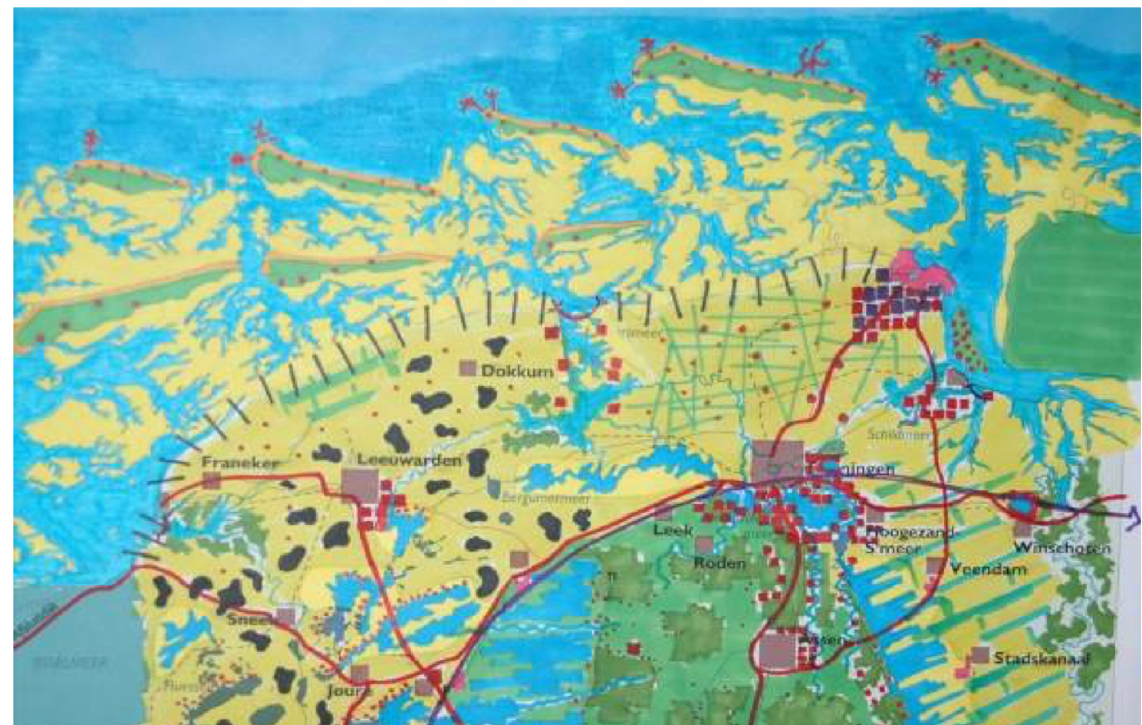
Figure 1. Plan for Double Defence (Roggema et al.,